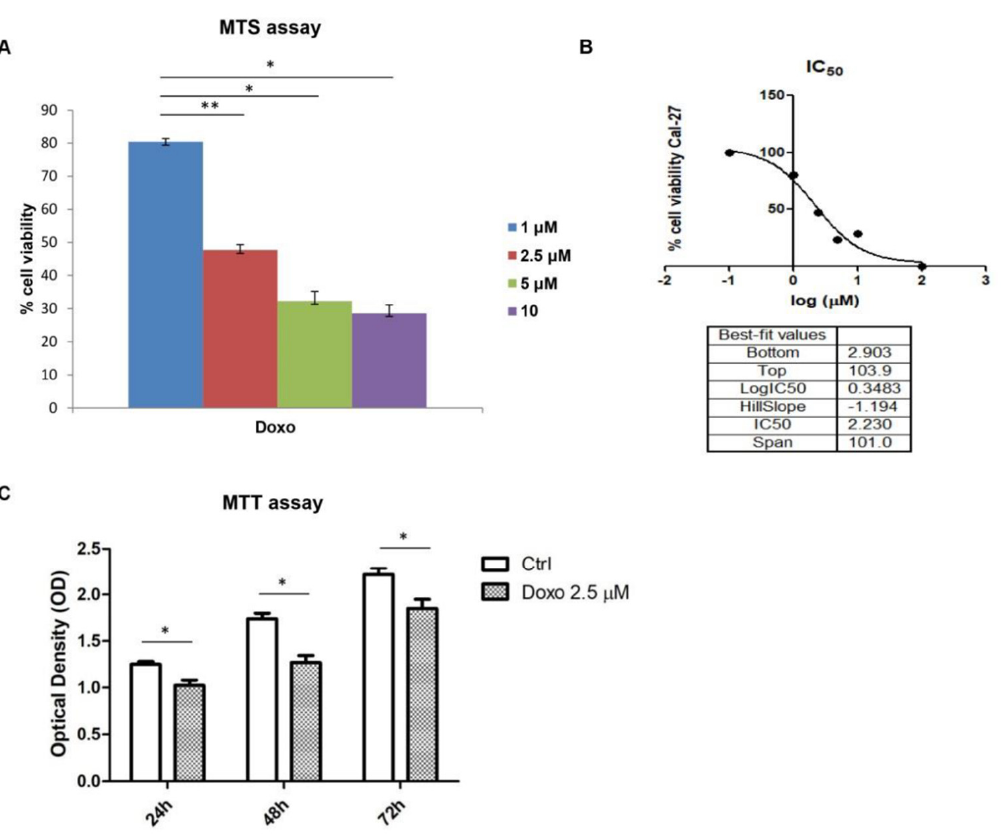
Figure 1. ( A ) Cell viability on Cal-27 cells treated with Doxo at 1, 2.5, 5 and 10 µM for 24 h. Cell viability was assessed using MTS assay and normalized to control cells treated with DMSO (0.2% as final concentration). ** p < 0.01; * p < 0.05. ( B ) the IC 50 value graph for Doxo. ( C ) MTT assay reported the Doxo treatment on Cal-27 cells at 24, 48 and 72 h. * p < 0.05.